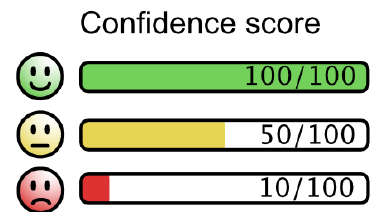
Figure 3. The form of the VC